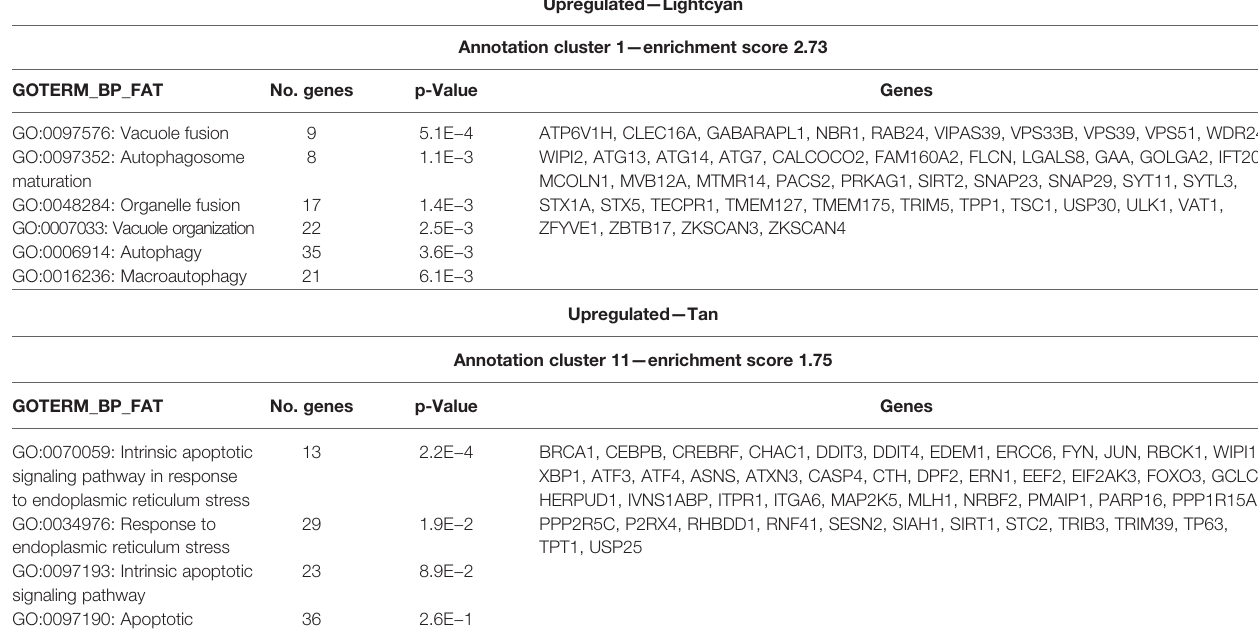
Upregulated — Lightcyan Annotation cluster 1 — enrichment score